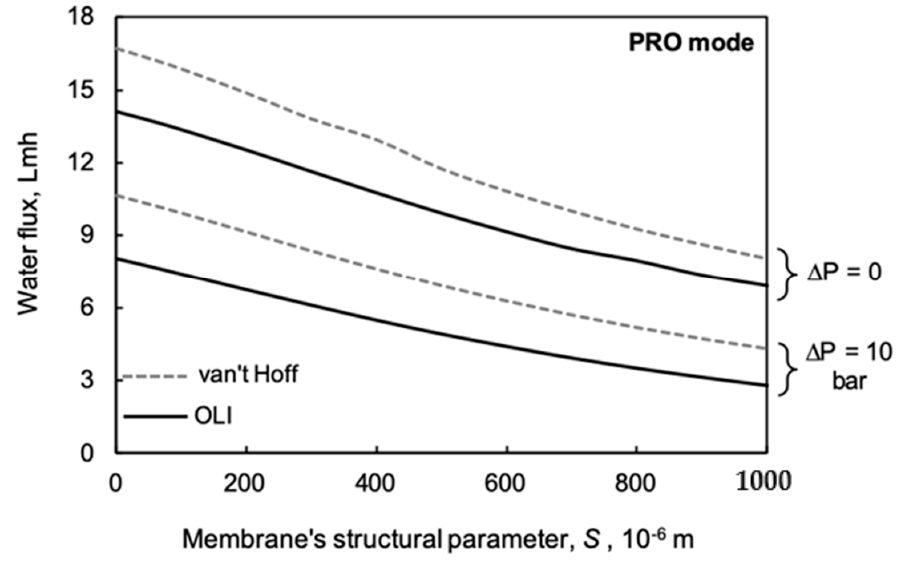
Figure 7. Water flux as a function of the membrane structural parameter at two different values of the hydraulic pressure (Other parameters are listed in Table 2) (1 Lmh = 0.2778 × 10 − 6 m/s).